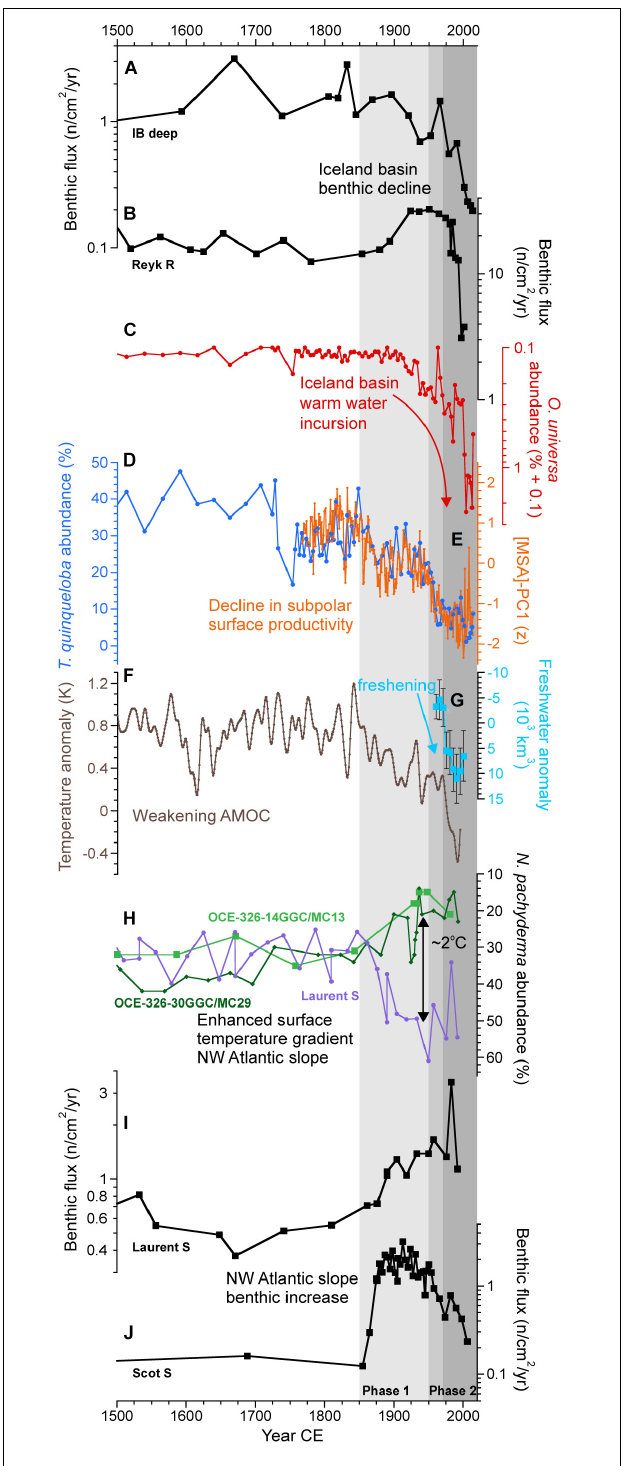
FIGURE 2 | Five hundred-year North Atlantic benthic foraminifera accumulation rates in relation to key oceanographic changes. (A) Benthic foraminifera flux in IB deep* (Spooner et al., 2020; this study); (B) Benthic foraminifera flux in Reyk R (this study); (C) % abundance of warm water O. universa in IB deep* (Spooner et al., 2020); (D,E) Indicators of Iceland